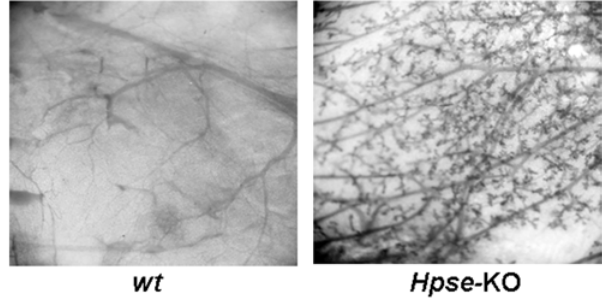
Figure 3. Morphological appearance of mammary glands from wt vs. Hpse -KO mice. Whole-mount preparations of mammary glands from 3-month-old virgin mice were stained with hematoxylin. Hpse- KO derived mammary glands (right panel) showed abundant side branches and alveolar structures compared with glands from age-matched wt animals (left